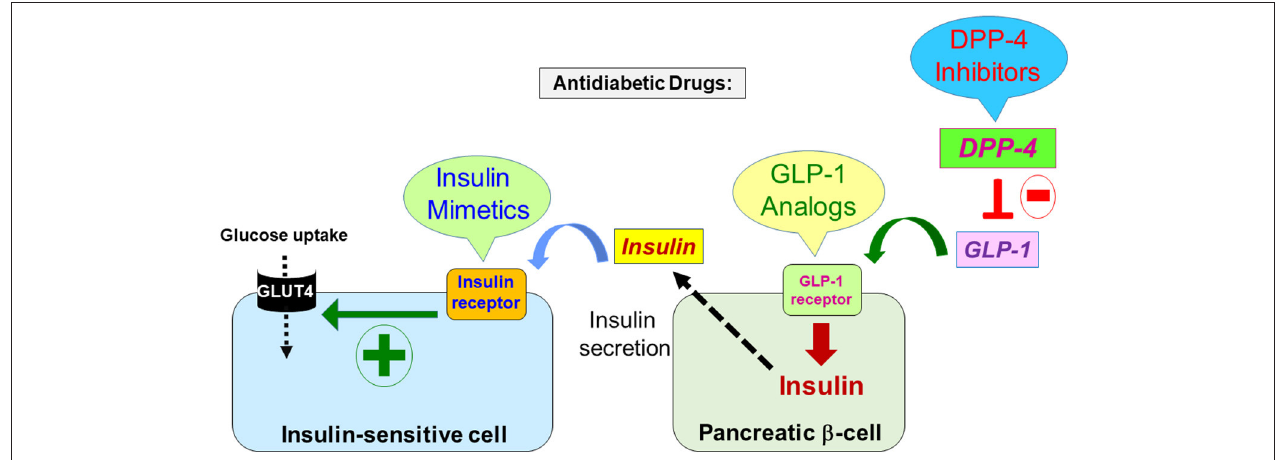
FIGURE 1 | Representative figure depicting some of the current antidiabetic strategies along with their molecular targets. At the molecular level, the major antidiabetic drugs aim either to increase the production and release of insulin by the pancreatic beta cells or to potentiate its biological activity in the major targets. Thus, the therapeutic molecules may be either insulin mimetics targeting and activating the insulin receptor in the insulin-sensitive cells that eventually leads to glucose uptake via the glucose transporter GLUT4; or GLP-1 receptor analogs that increase insulin synthesis and its secretion in the pancreatic beta-cell; or the inhibitors of the enzyme DPP-4 that result in the increase of GLP-1 levels controlling insulin synthesis and secretion via binding and activation of its receptor (GLP-1 receptor).